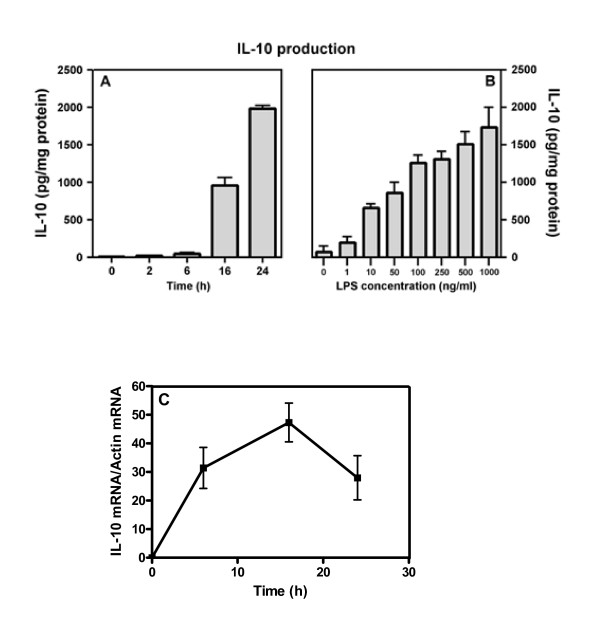
Time and dose dependency of IL-10 production in HAM stimulated by LPS. HAM were stimulated with LPS (1 μg/ml) and supernatant were collected after different incubation time and assayed for IL-10 content by ELISA for Panel A and by real time PCR for Panel C. Panel B: HAM were stimulated for 24 hours with increasing concentration of LPS and supernatant were assayed for IL-10 by ELISA.